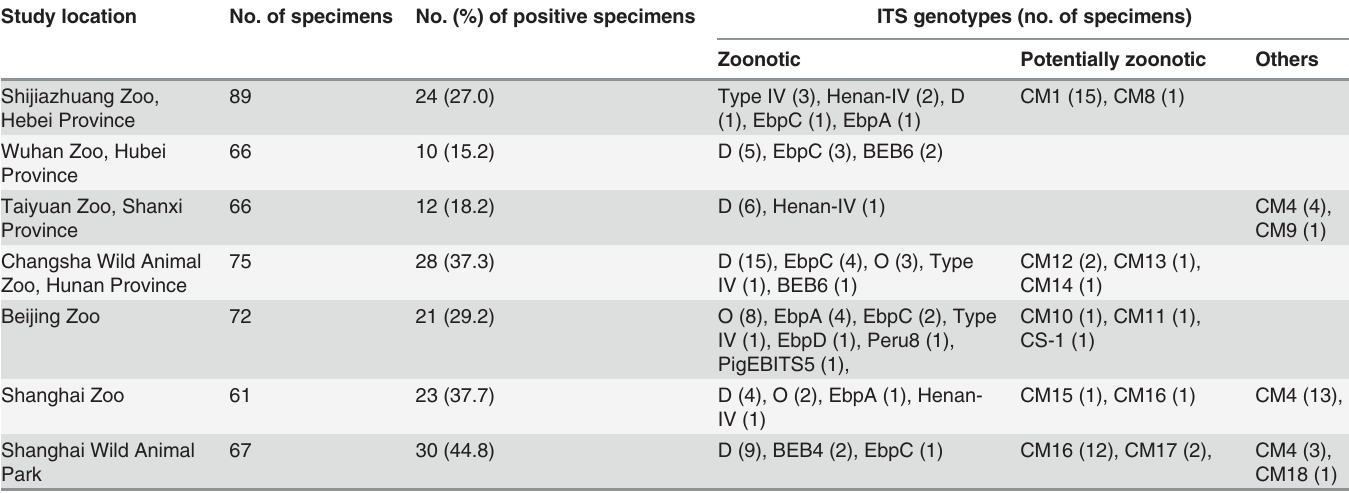
Table 1. Prevalence and ITS genotypes distribution of E . bieneusi in nonhuman primates in different zoos in China. Study location No. of specimens No. (%) of positive